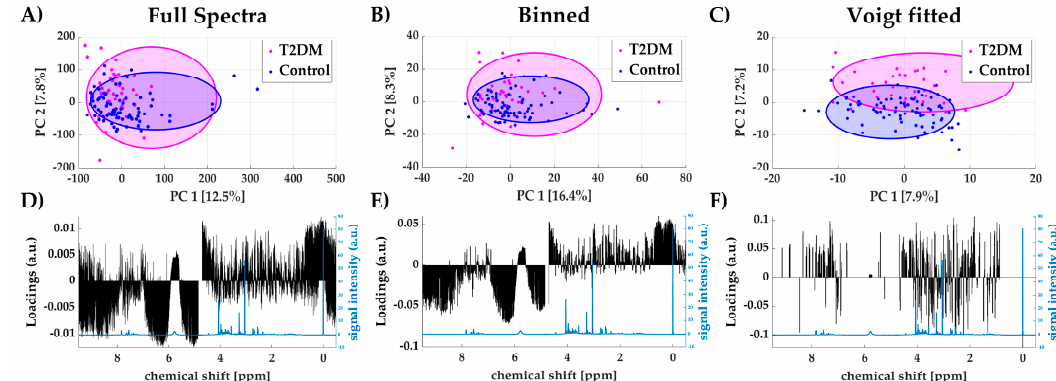
Figure 4. Scores plots of PC1 and PC2 using full spectra ( A ), binned data ( B ) and Voigt fitted data ( C ) including 95%- confidence ellipses for each group (Type 2 diabetes mellitus (T2DM) and control); loadings plot for PC1 for all three methods (black) with reference spectrum (blue) ( D – F ).